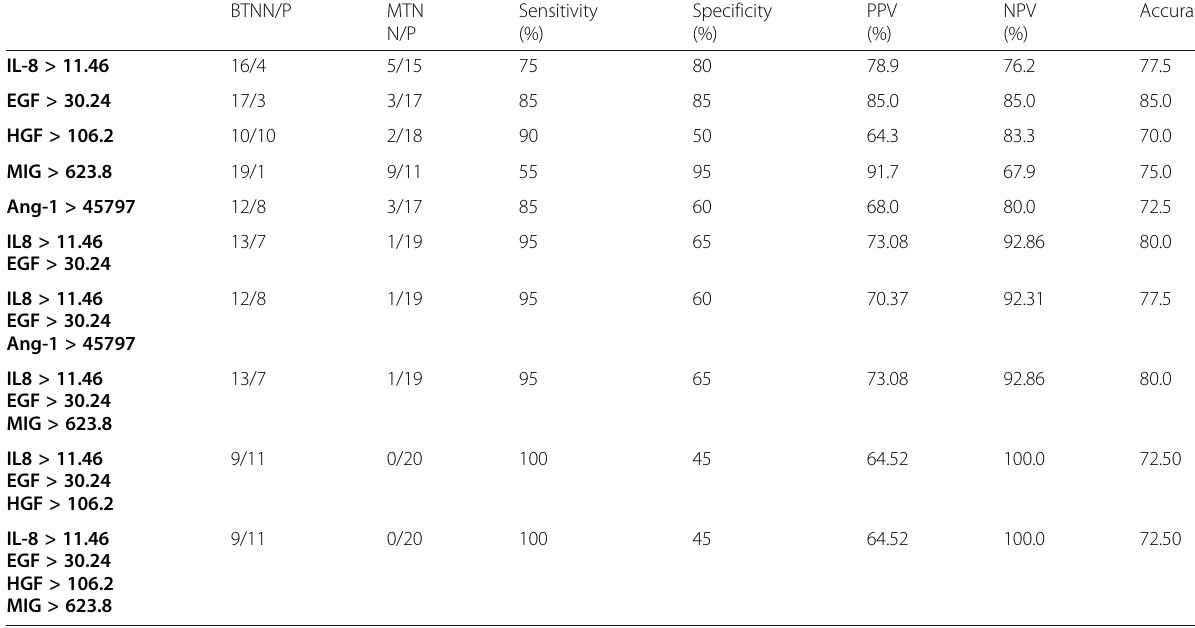
Table 5 Agreement and diagnostic performance of the significant serum